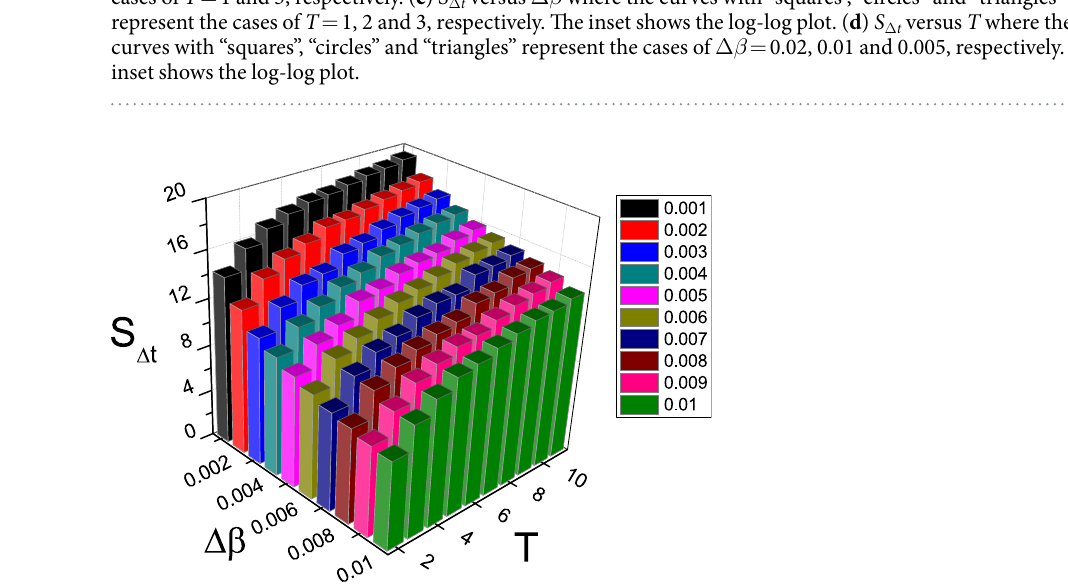
Figure 3. 3D plot of the dependence of S Δ t on the two parameters Δ β and T where the other parameters are the same as in Fig. 2(c) and